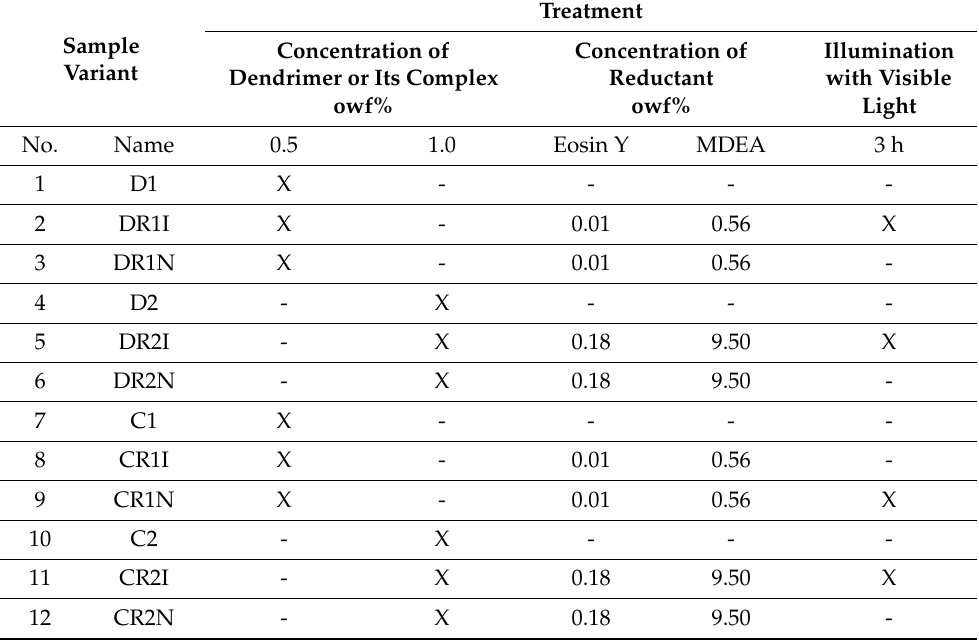
Table 1. Procedures used for treating the different